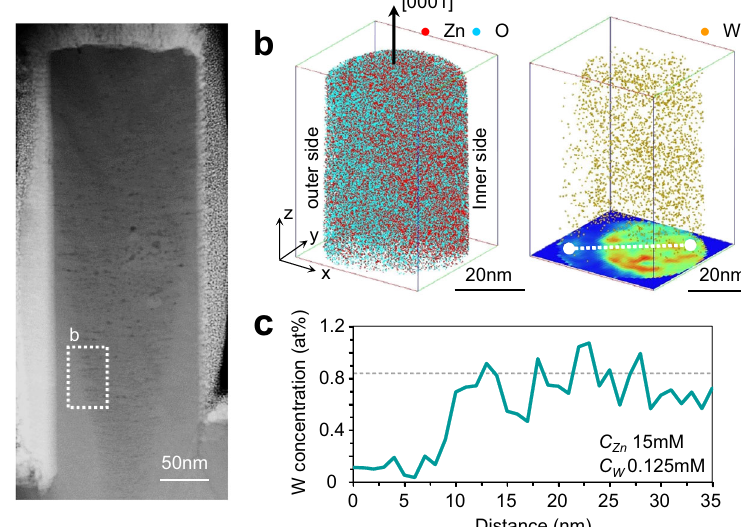
Fig. 4 Spatial composition analyses of nanowires. a HAADF-STEM image of ZnO nanowire grown with C Zn 15 mM and C W 0.125 mM. b 3D atom maps for Zn, O (left), and W (right) taken around the projected area in a . 2D W concentration plot in z direction is shown at the bottom of 3D W atom map. c Line pro fi le of W concentration along the dotted line in 2D W concetration plot of b . The dotted line is W concentration in